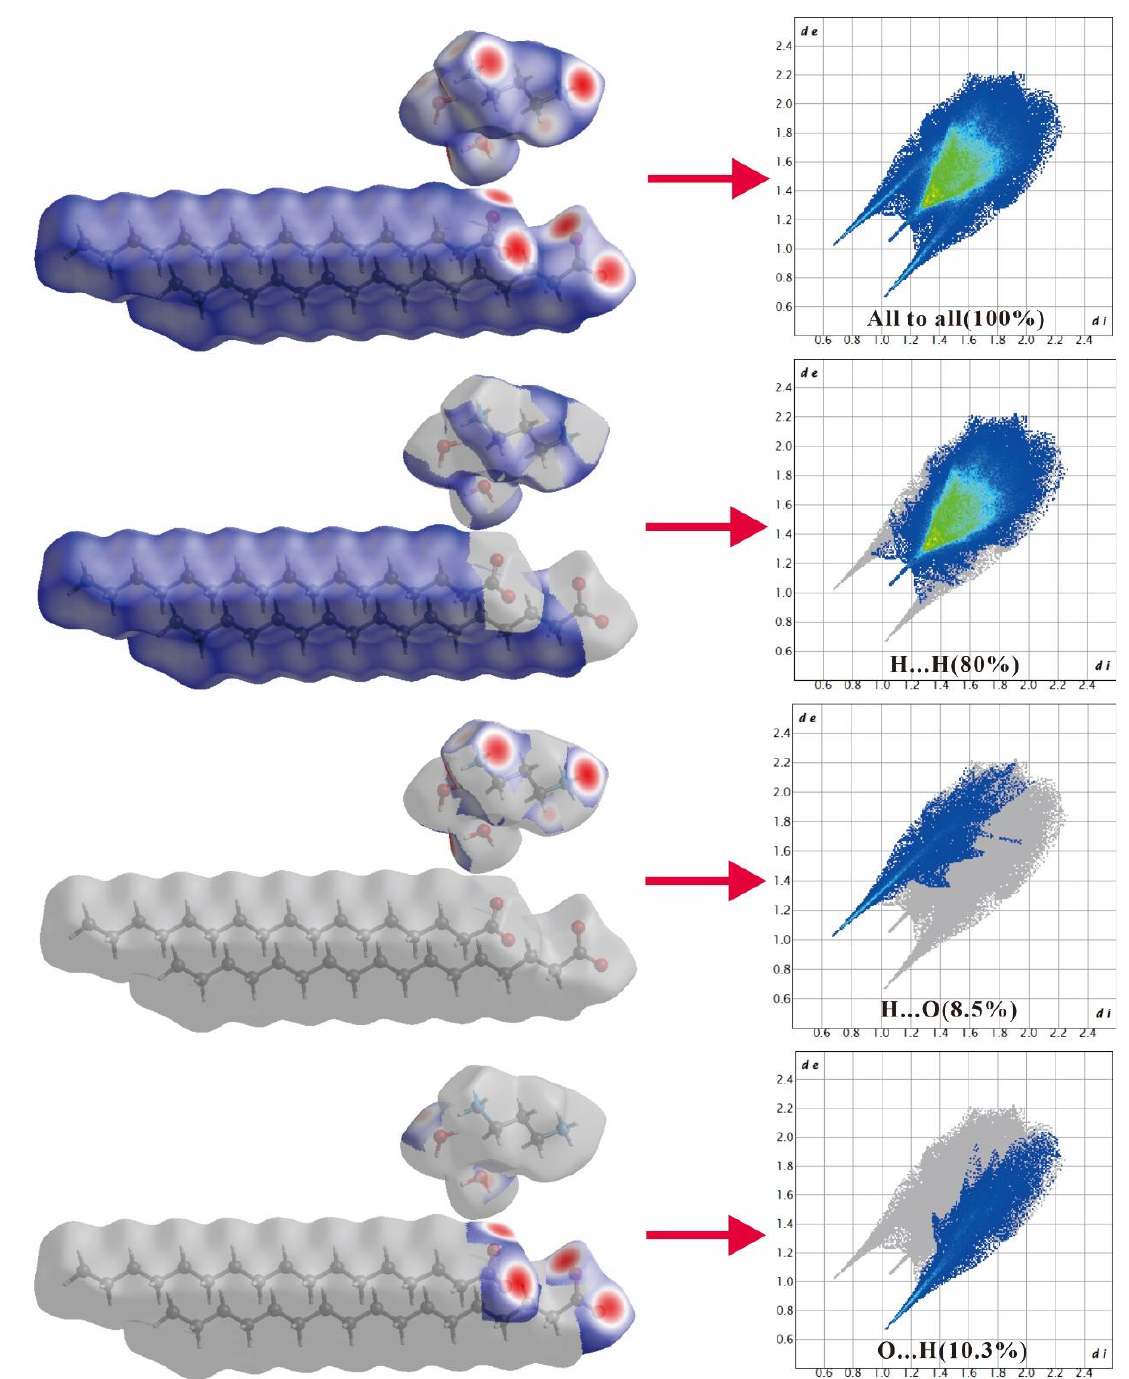
Figure 6. Hirshfeld surface and 2D fingerprint plots for H in molecule 3C17, broken down into contributions from specific pairs of atom types. The mechanical strength of a single crystal is related to the spatial crystal